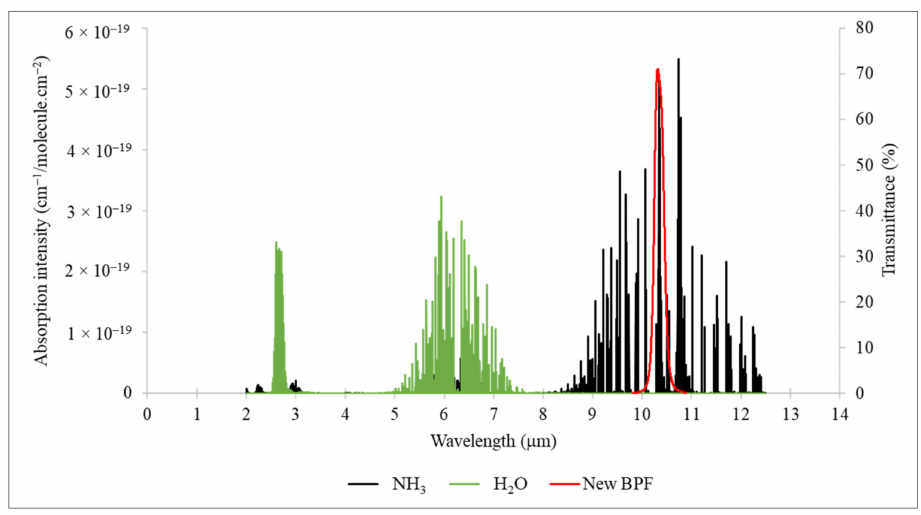
Figure 4. NH 3 and H 2 O spectra with data from the HITRAN database [27] and those of the feasible BPF.